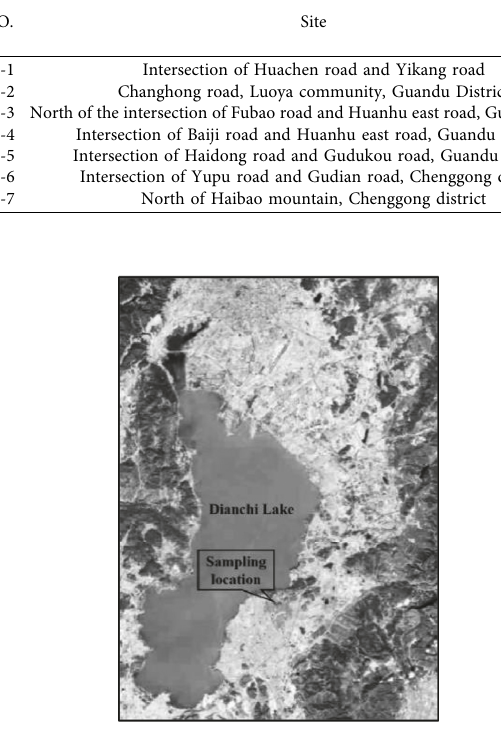
Figure 2: Location of borrow site for test soil.